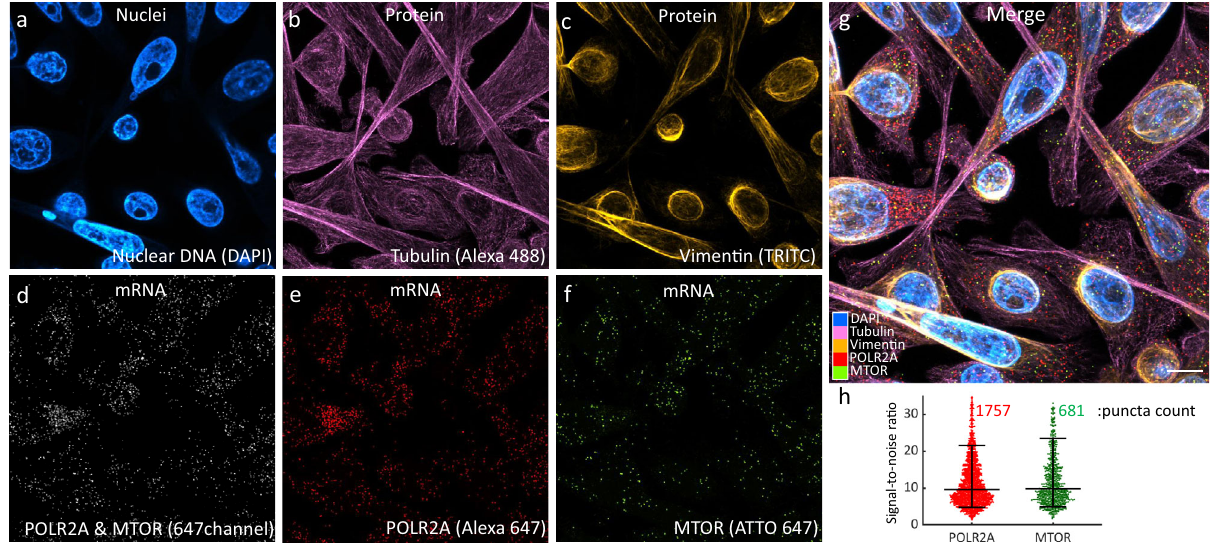
Fig. 6 Simultaneous 4-plex co-detection of protein and mRNA in colorectal cancer SW480 cells. a Intensity imaging showing nuclei labeled with DAPI. b Intensity image showing Tubulin protein labeled with Alexa488. c Intensity image showing Vimentin protein labeled with TRITC. d Intensity image at 647 nm showing mRNA targets, POLR2A and MTOR, which were further resolved by lifetime. e Unmixed lifetime image showing POLR2A puncta labeled with Alexa647. f Unmixed lifetime image showing mTOR puncta labeled with ATTO647. g Merged image of all channels. Scale bar is 10 µ m. h Signal-to noise and puncta count analysis for the mRNA targets. Overlaid lines correspond to quantiles [10,50,90]%, n = 1757 and n = 681 transcripts respectively. Source data are provided as a Source Data fi